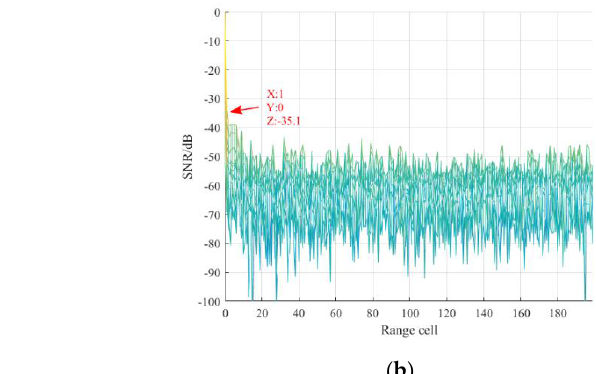
Sensors 2021 , 21 , x FOR PEER REVIEW